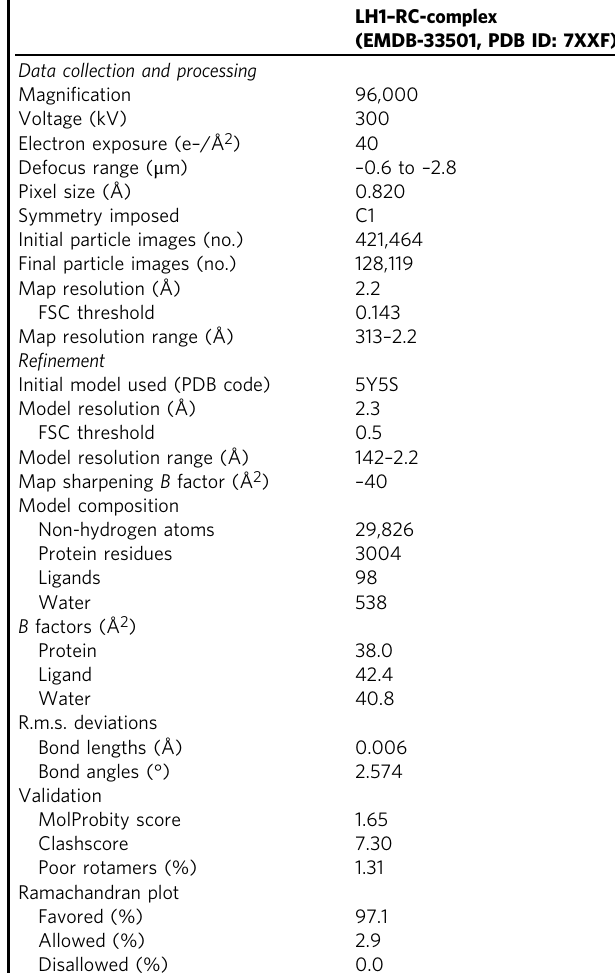
Table 1 Cryo-EM data collection, re fi nement, and